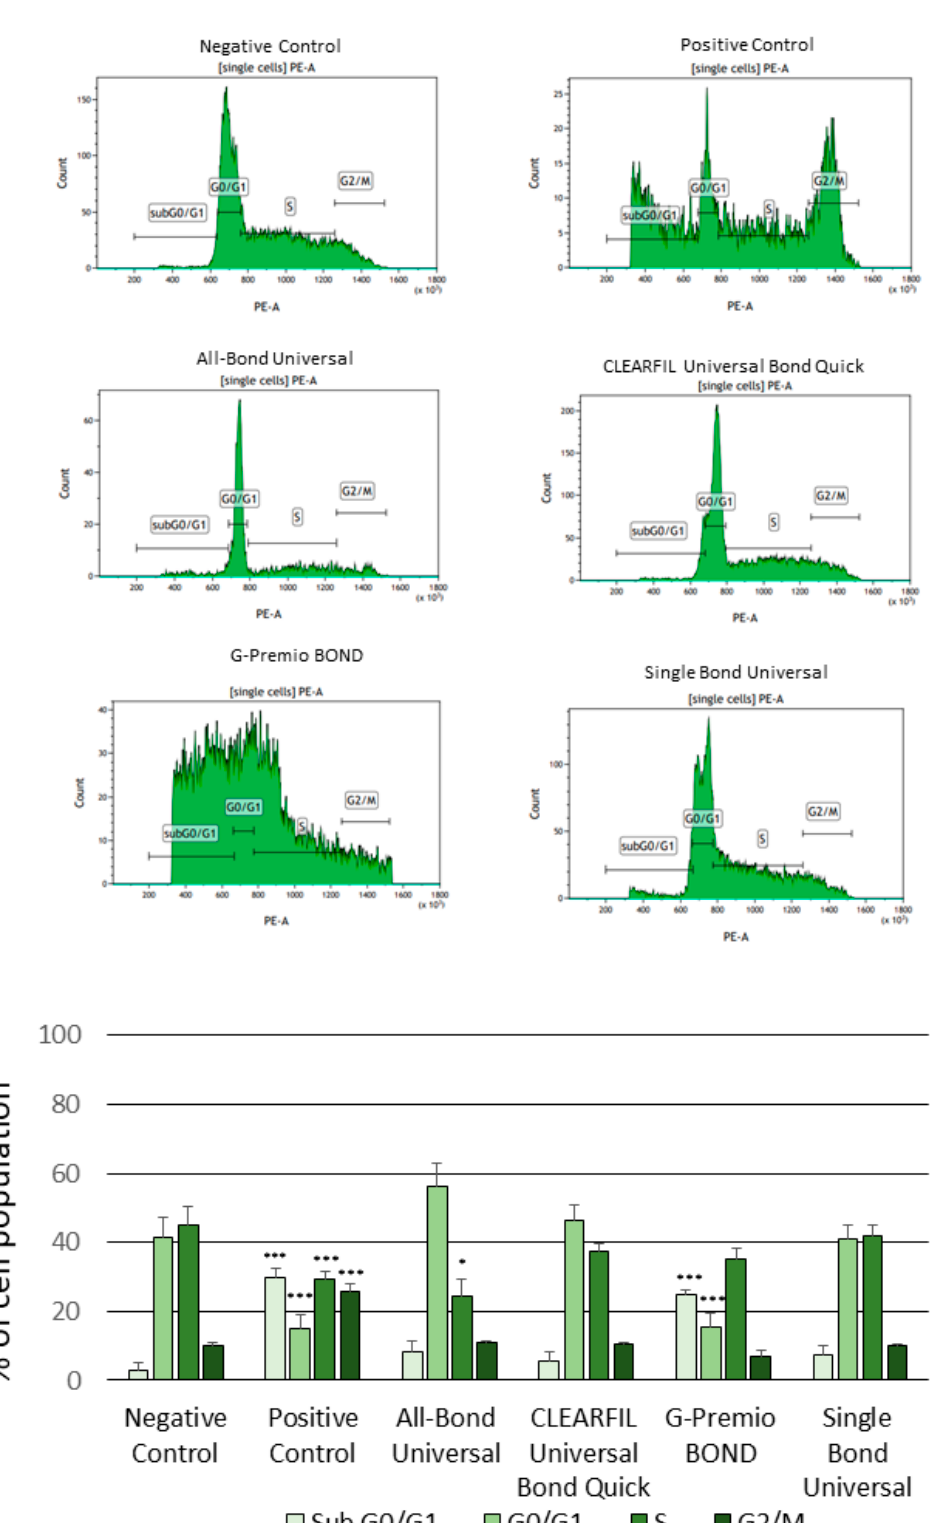
Figure 4. Flow cytometry (FC) analysis of cell cycle progression using the propidium iodide (PI) staining after 24h incubation of cells with the tested compounds. Cells treated with 1 µM nocodazole constituted a positive control. Cells cultured in the complete medium constituted a negative control. The differences were statistically significant on the graphs as follows: * p < 0.01, *** p < 0.001 versus negative control.